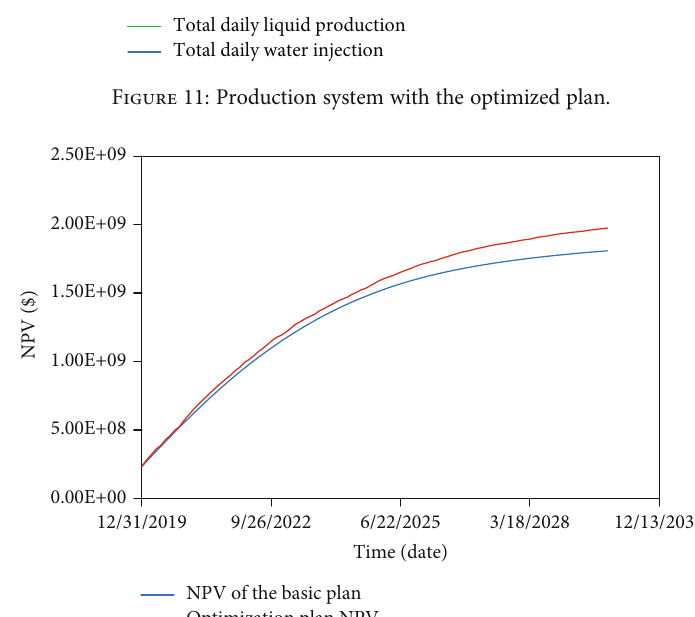
Figure 12: NPV comparison in the next 10